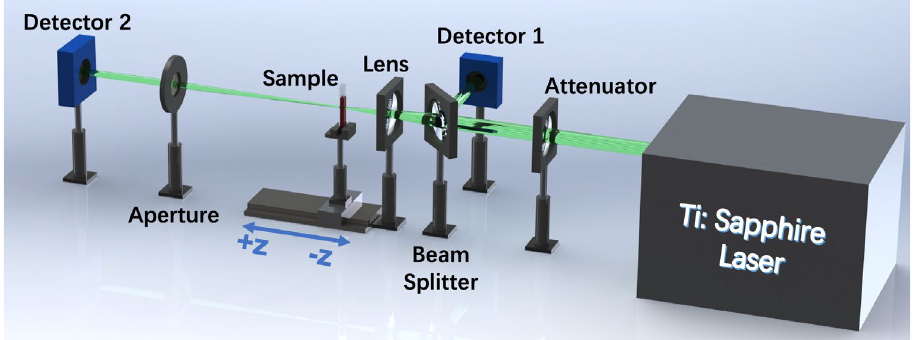
Figure 4. Schematic diagram of the OA Z-scan.